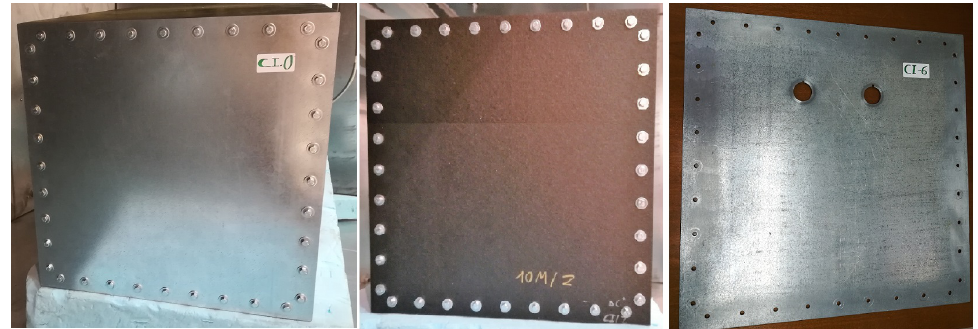
Figure 3. Test cases for the nested RC measurements: CI-0 ( left ); CI-2 ( middle ); and CI-6 ( right ).